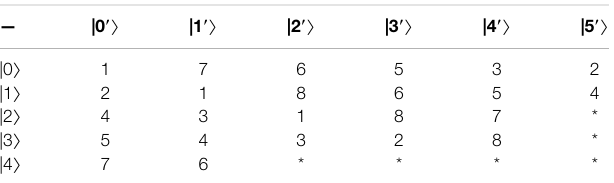
TABLE 12 | 8×3+0,×,4=24-member.